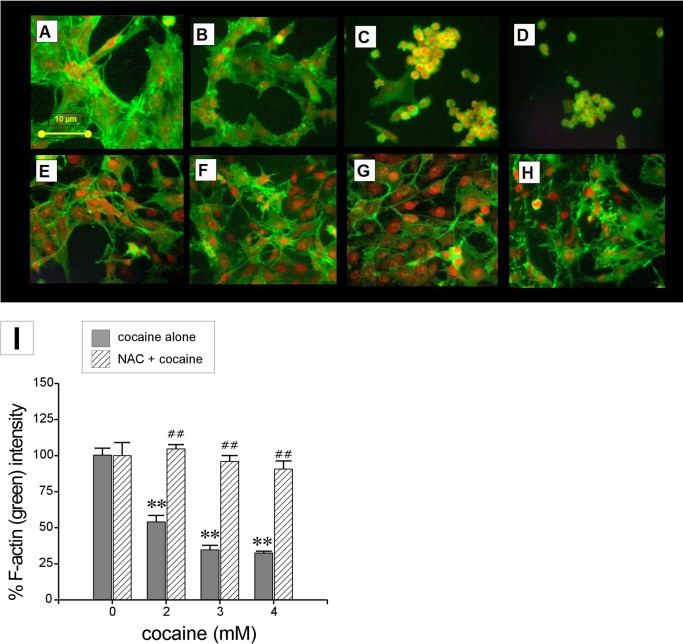
Effects of cocaine on nuclear morphology and F-actin cytoskeleton in astroglia-like cells.Photomicrographs showing cells treated with PBS (controls, A); cocaine alone 2, 3 and 4 mM, B-D respectively); NAC alone (5 mM, E); pretreatment with NAC (30 min) followed by a 1h exposure to cocaine (2, 3 and 4 mM, F-H respectively). Cells were incubated with PI (5 μg/ml) and then Alexa Fluor 488 Phalloidin (6.6 μM) before being imaged on an inverted fluorescent microscope with a 40x objective. Images show changes in structural cytoskeleton captured by F-actin phalloidin staining and counterstaining with PI. Fluorescence intensity for phalloidin staining (I) was quantified using image J software. Data represent mean intensity ± S.E.M. (n = 3, **P<0.01 significance of comparison with corresponding control; ##
P>0.05 insignificance of comparison with corresponding control.